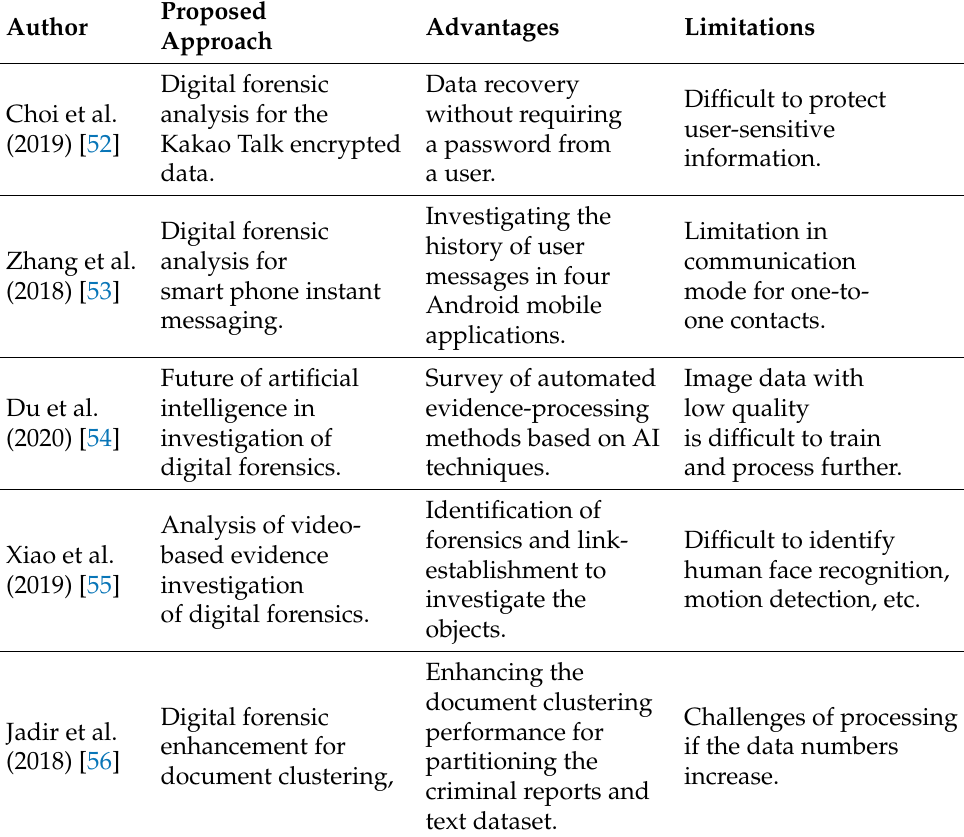
Table 1. Comparison of the recent state-of-the-art DF